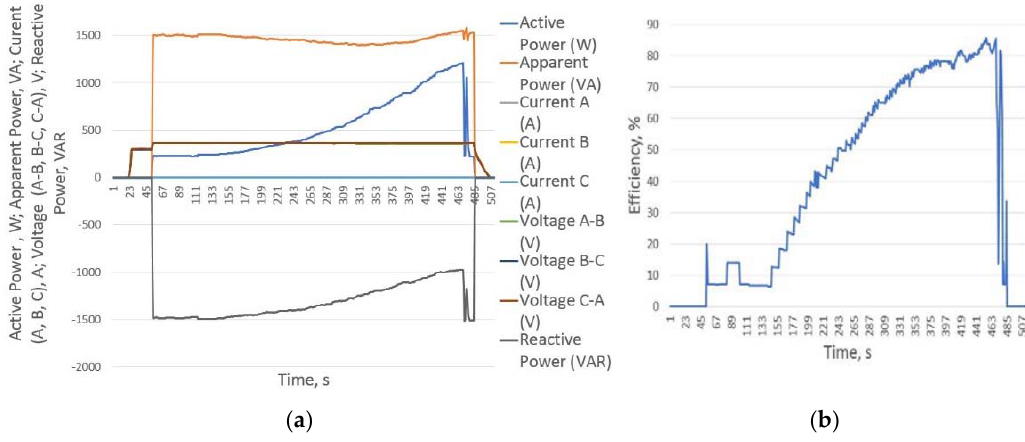
Figure 10. The results of the PMSM efficiency determination experiment with an increased voltage of 360 V applied during the experiment. ( a ) Electrical PMSM input parameters; ( b ) efficiency curve.